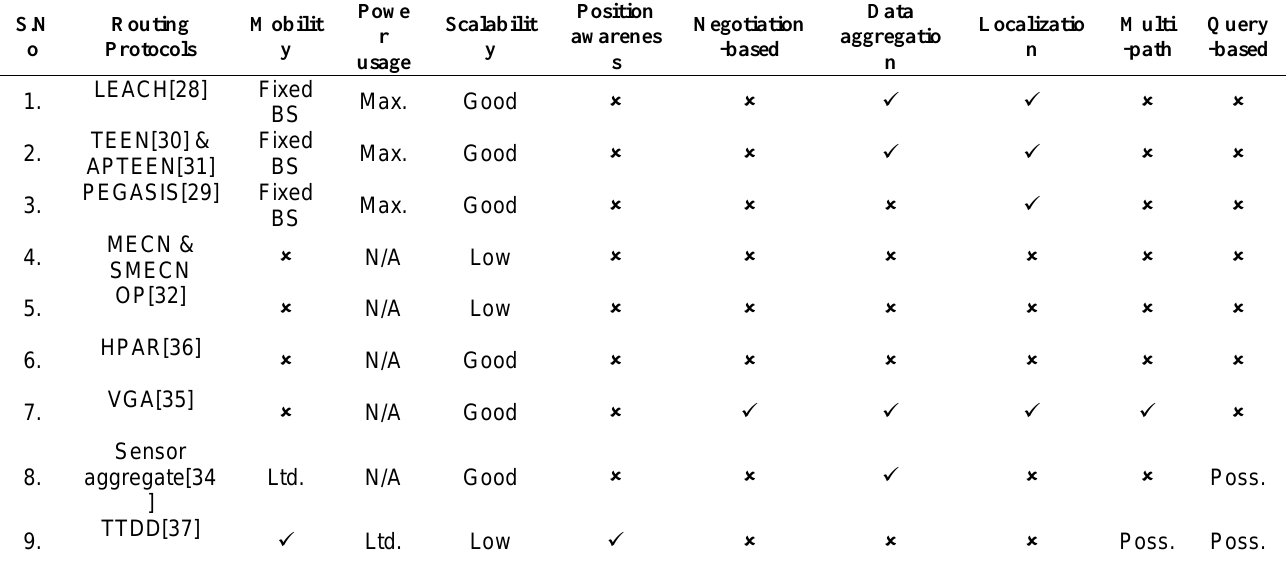
Table 3. Classification of hierarchical network based routing